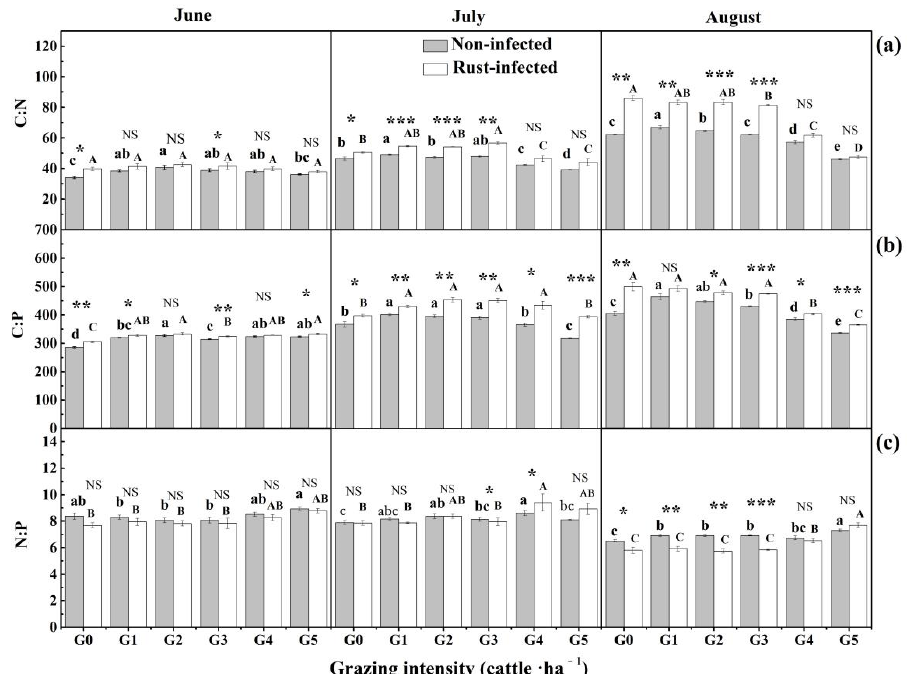
Figure 4. Influence of grazing intensity on the C:N ( a ), C:P ( b ), and N:P ( c ) ratios of non-infected and rust-infected Leymus chinensis from June to August based on the 2-year (2015 and 2016) average (error bars denote standard errors). Different lower-case and upper-case indicate significant differences among grazing intensities. The asterisk (*) indicates significant differences between non-infected and rust-infected plants (***, p < 0.001; **, p < 0.01; *, p < 0.05; NS, p > 0.05). 3.3. The Relationship between Relative Growth Rate and C:N:P Stoichiometry For non-infected and rust-infected plants, the ratios of N:C and P:C increased with the relative growth rates. The higher growth rates correspond to a higher N:C and P:C ratios (Figure 5).